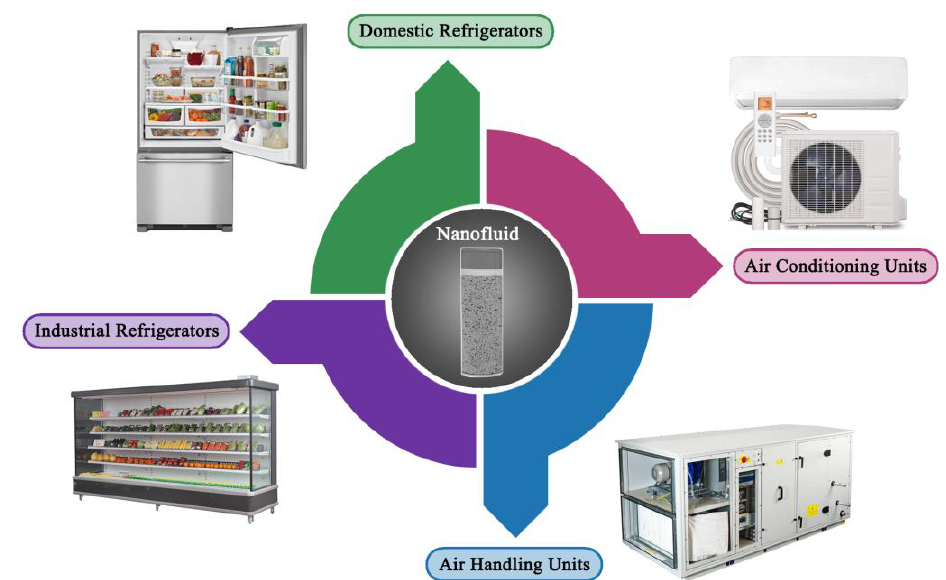
Figure 23. Nanofluids employment in AC&R applications, namely; air conditioning units, air handling units, industrial refrigerators, and domestic refrigerators.